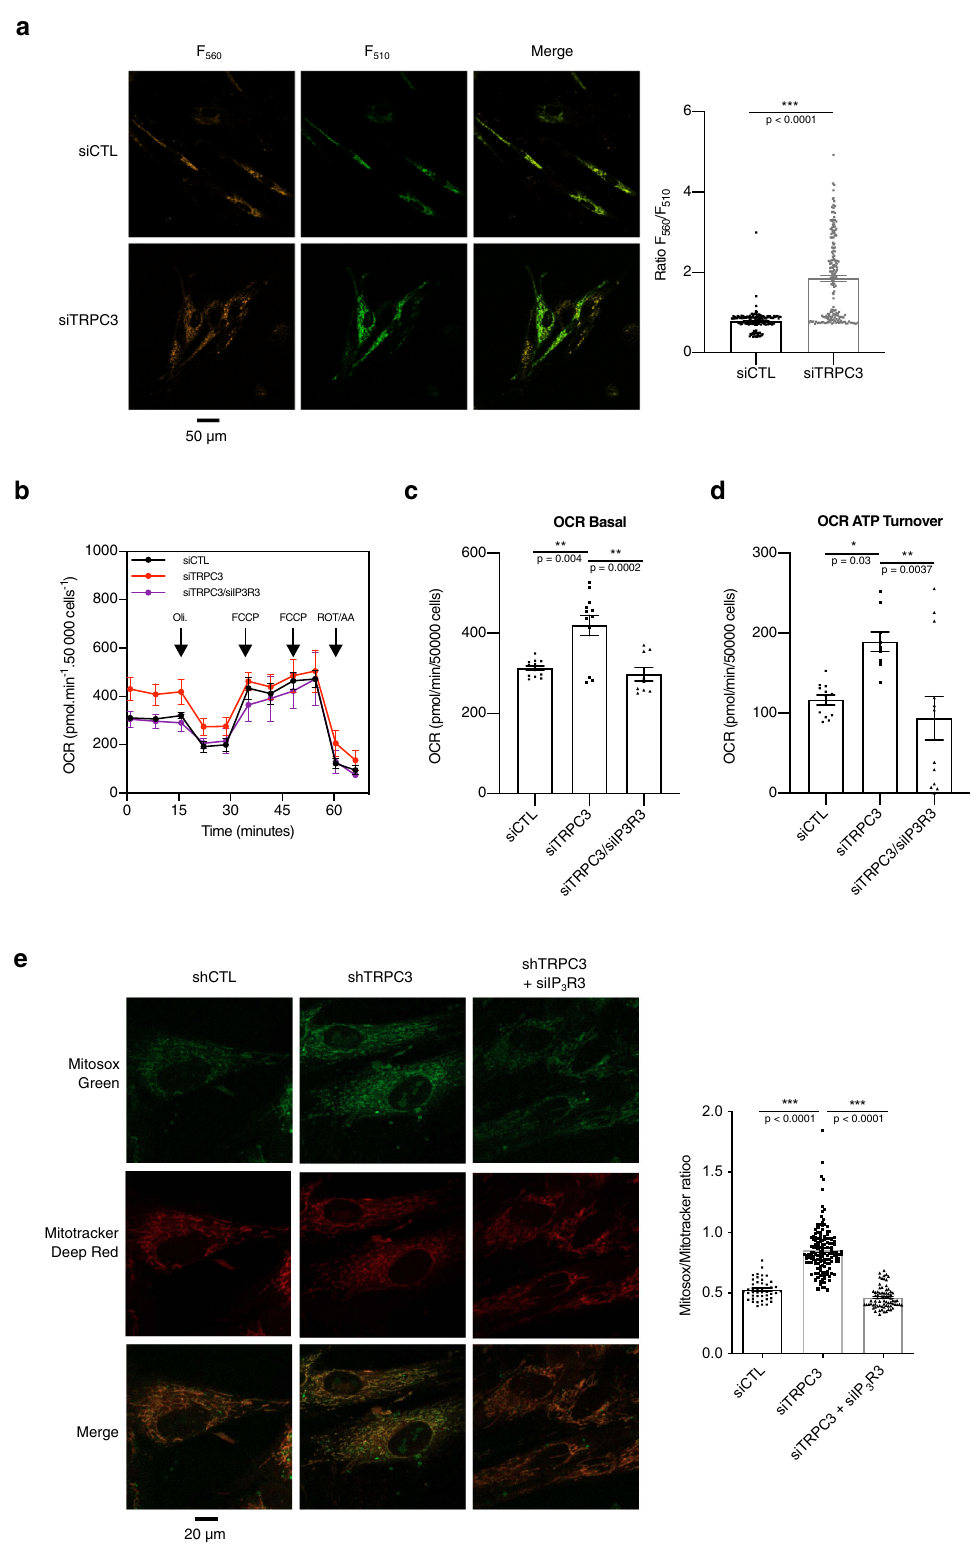
was captured at wavelengths 505 – 545nm. TMRE and ER-Tracker Red were excited by the 543nm line of 5mW He/Ne laser (Laser-Fertigung, Hamburg, Germany) and fl uorescence was captured at wavelengths >560nm. CellMask Deep Red was excited by the 633 nm line of 15mW He/Ne laser (Laser-Fertigung, Hamburg, Germany) and the fl uorescence was captured at wavelengths >650